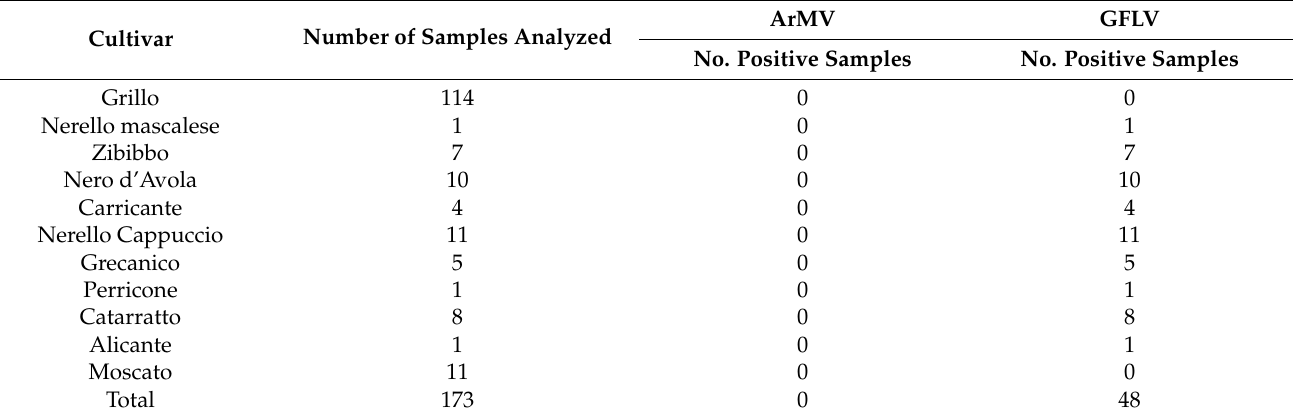
Table 3. Number of samples analyzed by RT-PCR with specific primer pairs for Arabis mosaic virus and Grapevine fanleaf virus.